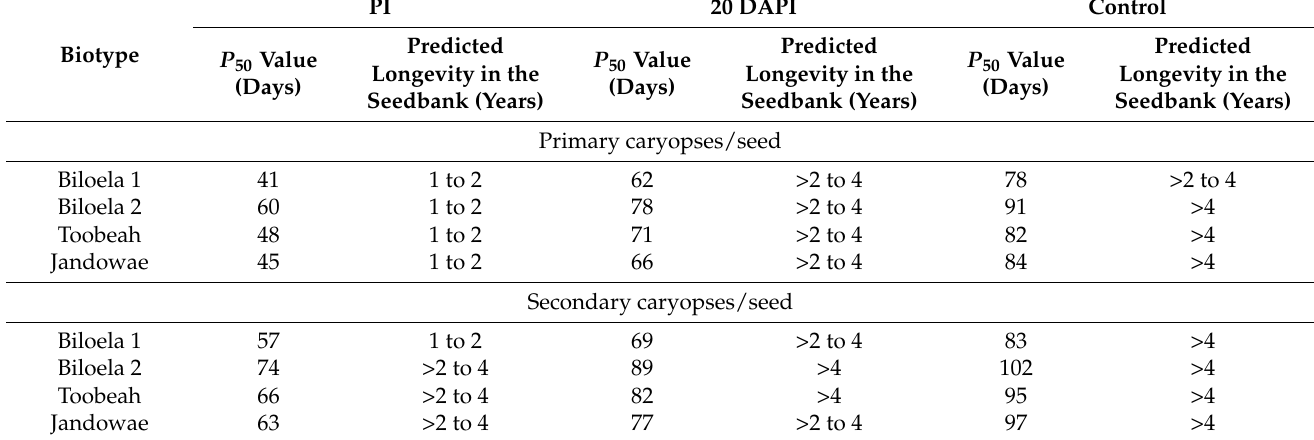
Table 3. Response of primary and secondary caryopses of four biotypes of Avena sterilis ssp. lu- doviciana to controlled aging test (CAT) at 48 ◦ C and 60% RH and their predicted longevity in soil. Caryopses used were produced under elevated temperature applied at panicle initiation (PI) and 20 days after panicle initiation (20 DAPI) along with a control (no imposition of elevated temper- ature). Caryopses that lost 50% viability ( P 50 ) in 40 days were categorized as transient (predicted longevity in the soil <1 year), caryopses reaching P 50 in >40 to 60 days were categorized as short- lived (predicted longevity 1 to 2 years), reaching P 50 in >60 to 80 days categorized as medium-lived (predicted longevity >2 to 4 years), and reaching P 50 in >80 days categorized as long-lived (predicted longevity >4